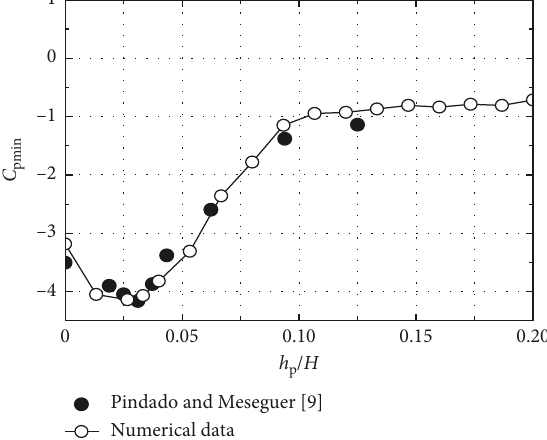
Figure 8: Variation of the highest mean suction on the roof with the relative parapet height h p / H